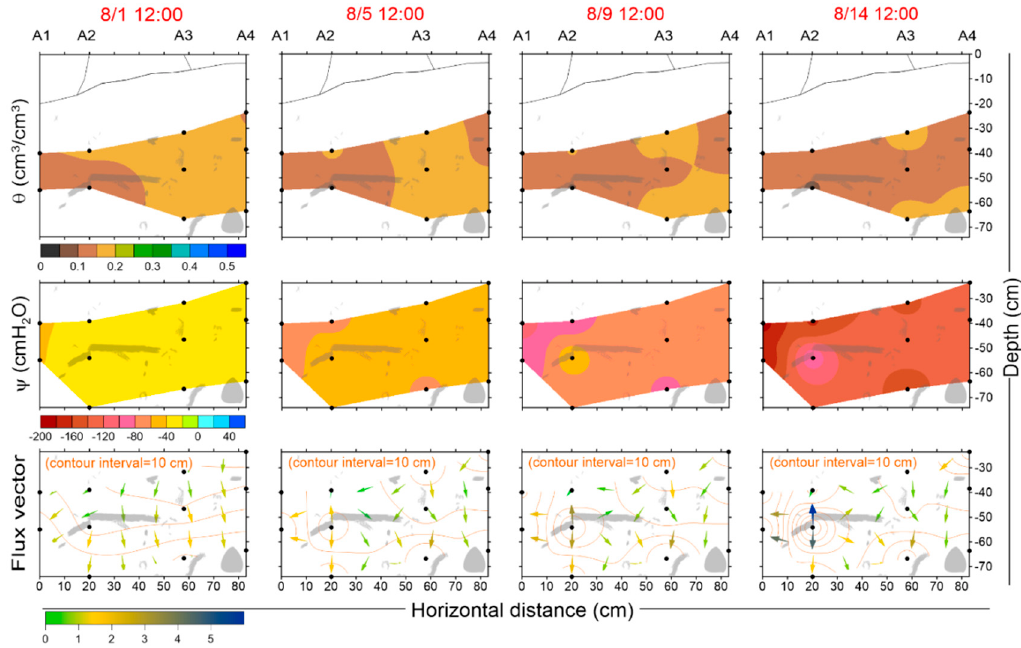
Figure 9. Spatial distributions of soil water content ( θ ), soil water potential ( ψ ), and flux vectors at four time points during the drying period from 31 July to 15 August 2013. Other details are as described for Figure 5.